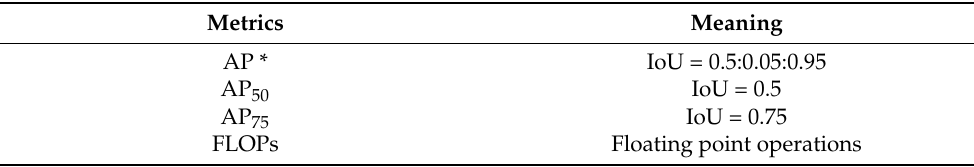
Table 1. Metrics of ablation